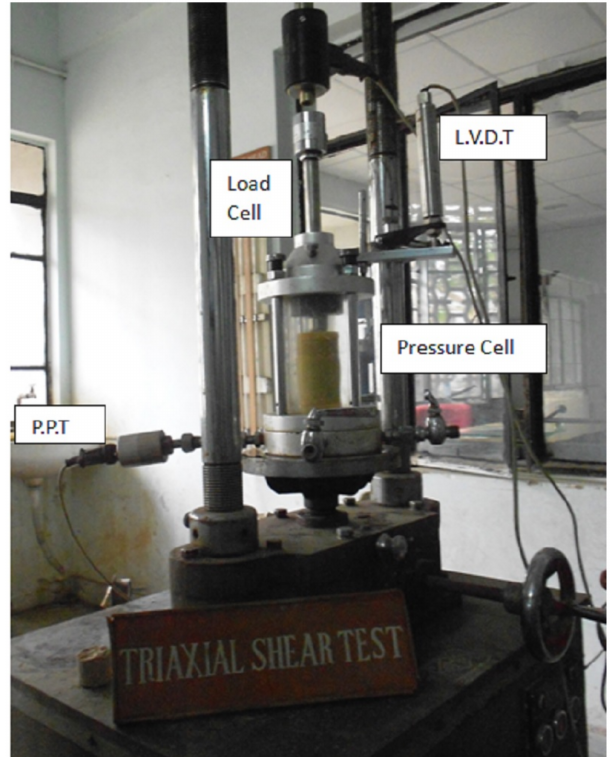
Figure 8. Triaxial shear test apparatus with LVDT, PPT, and load